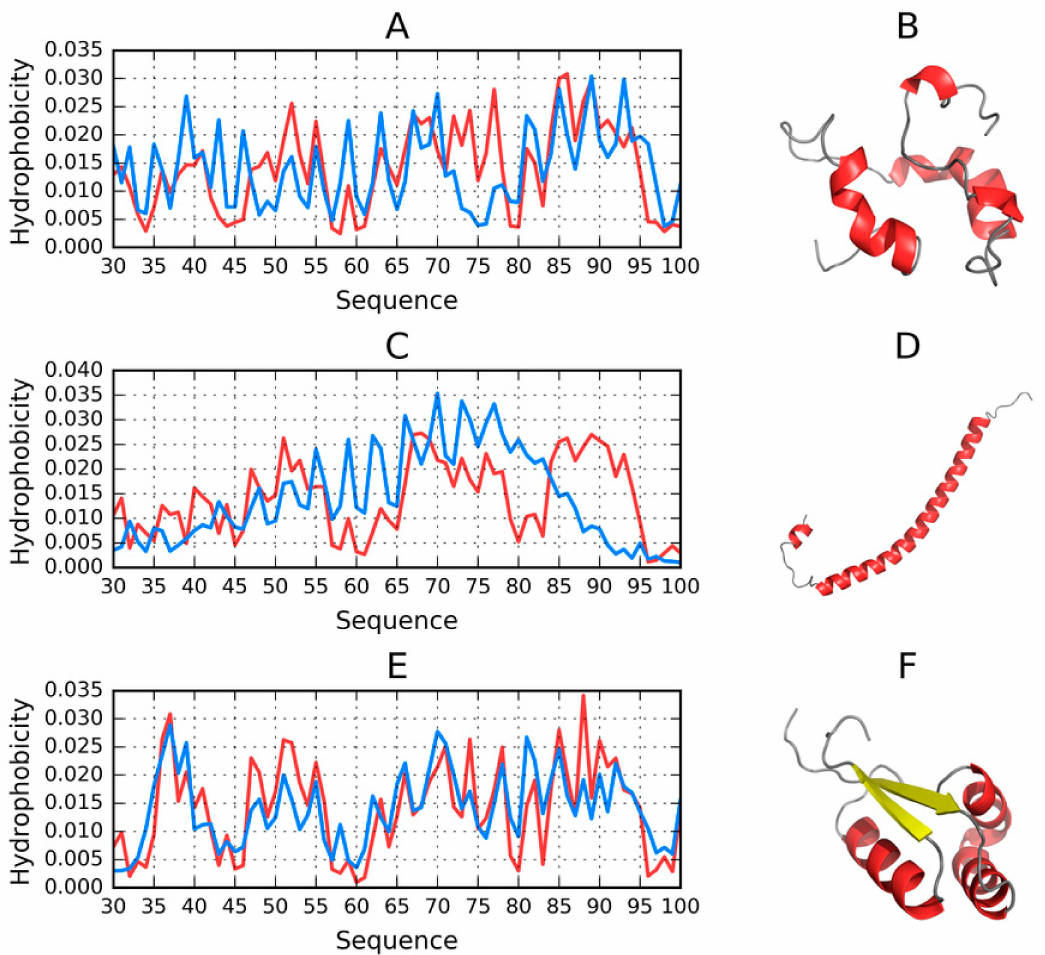
Figure 7. 3D visualizations along with theoretical (T, blue) and observed (O, red) hydrophobicity density distribution profiles for models of the 30–100 fragment, produced by each software package and characterized by the lowest RD. ( A , B )—FOD_1_(289); ( C , D )—ITASSER_1_(1); ( E , F